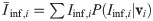
Inferring the perceived stimulus level from C. elegans escape behavior.The first row shows the conditional distributions of the inferred current vs. the actual applied current, partitioned into five bins, Pcontrol(Iinf|Iμ). Inference is done with the model of the control worm behavior. Panels (A), (B), (C) show the averaged probability of inferred laser current for the control, ibuprofen, and mutant worms, respectively. The second row shows the expected inferred laser current for each trial, I¯inf,i=∑Iinf,iP(Iinf,i|vi) vs. the applied current Ii. The inference is again done using the control model, and panels (D), (E), (F) show the three worm types. The panel (D), (E), (F) is different from (A), (B), (C) since the first three show the average probability of inferred laser current while last three show the individual expected value of inferred laser current.